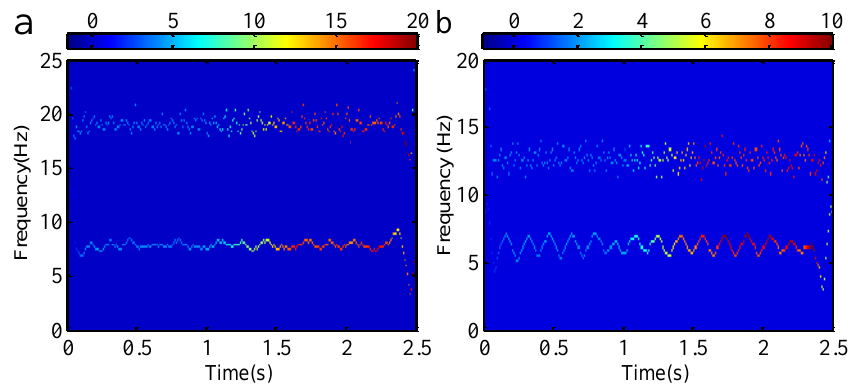
Figure 5. ( a ) Hilbert spectrum of real component; ( b ) Hilbert spectrum of imaginary component. Colors indicate the amplitude magnitude.